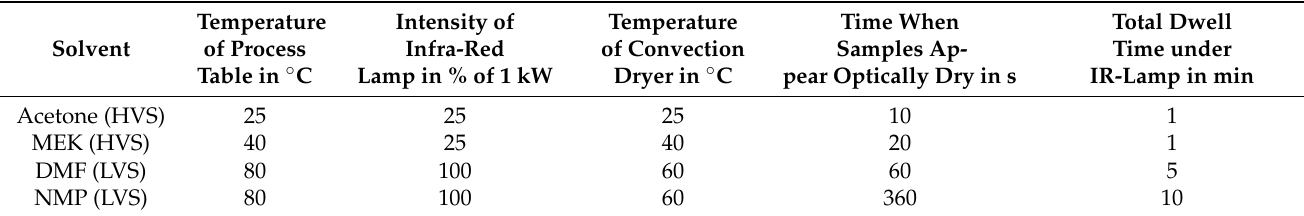
Table 2. Adjusted parameters of polymer solution drying process in the doctor blade coating machine. Temperature Solvent of Process Table in ◦